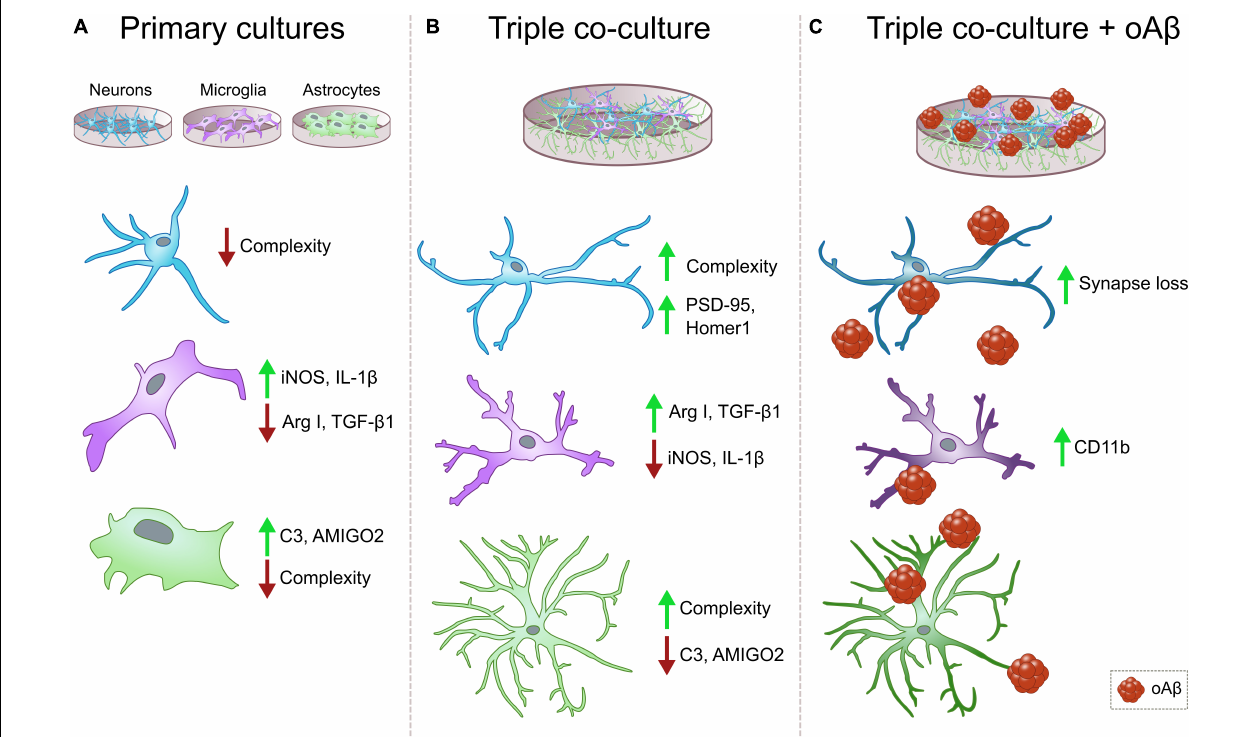
FIGURE 5 | Summary diagrams of individual vs. triple co-cultures and in the context of AD. (A) Classical individual primary cultures often exhibit significant alterations in comparison with cells in physiological conditions. Neurons and microglia display low morphological complexity, and both microglia and astrocytes increase the expression of pro-inflammatory markers iNOS, IL1 β and C3, and AMIGO2, respectively. (B) In our triple co-culture, neurons develop more complex morphologies and increased post-synaptic markers PSD-95 and Homer1. Microglia lower their expression of pro-inflammatory markers such as iNOS and IL-1 β , and increase anti-inflammatory markers Arg I and TGF- β 1. Lastly, astrocytes reduce the expression of pro-inflammatory markers C3 and AMIGO2, while they develop ramifications that resemble physiological conditions. (C) In the triple co-culture, A β 1-42 oligomers are able to induce synaptic loss and increase microglial marker CD11b, which makes this triple co-culture a suitable model to study amyloid pathology associated changes in vitro . Neurons, blue cells, microglia, purple cells, astrocytes, green cells, oA β , oligomeric A β